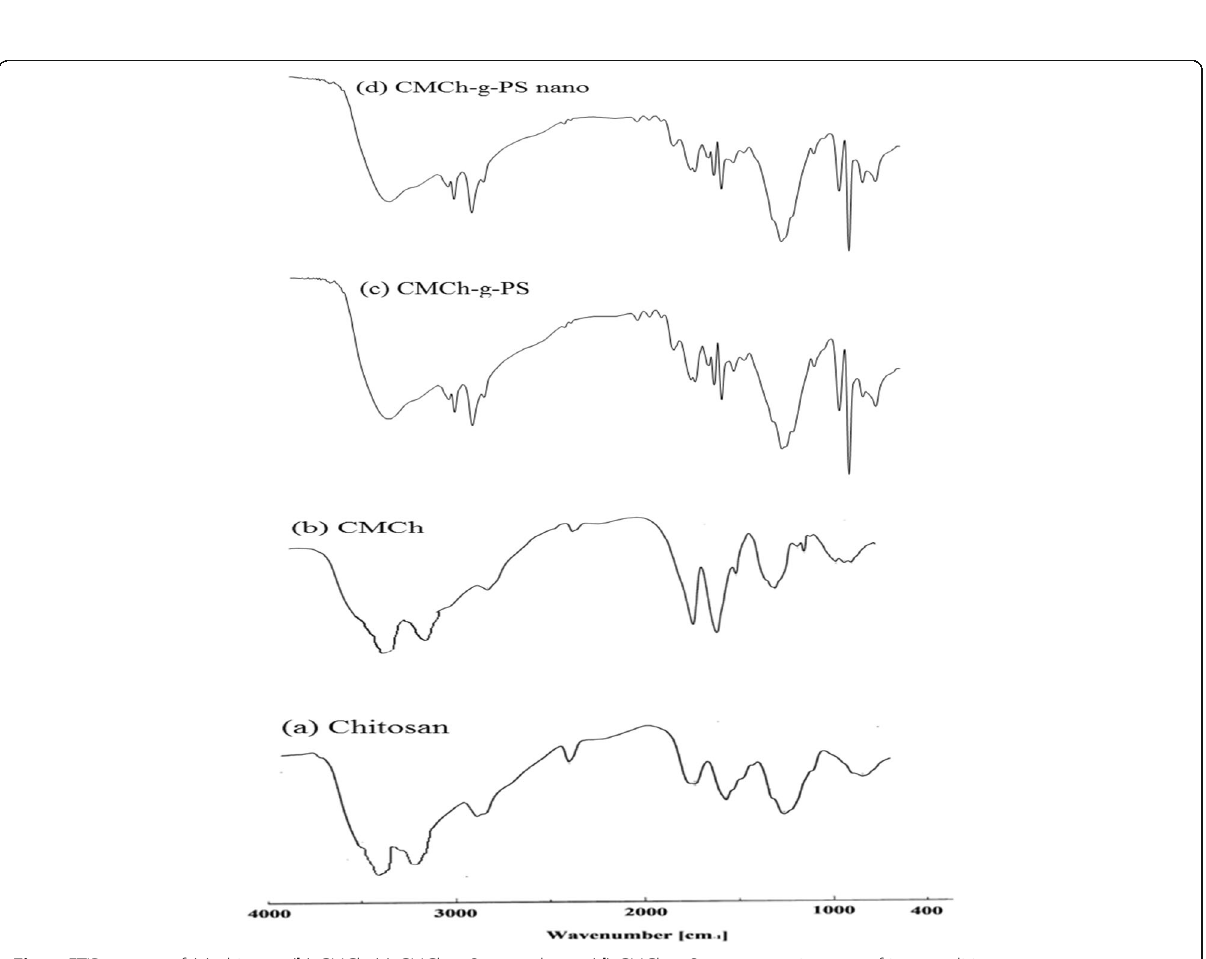
Fig. 5 FTIR spectra of ( a ) chitosan ( b ) CMCh ( c ) CMCh-g-Sty copolymer ( d ) CMCh-g-S nano at optimum grafting conditions